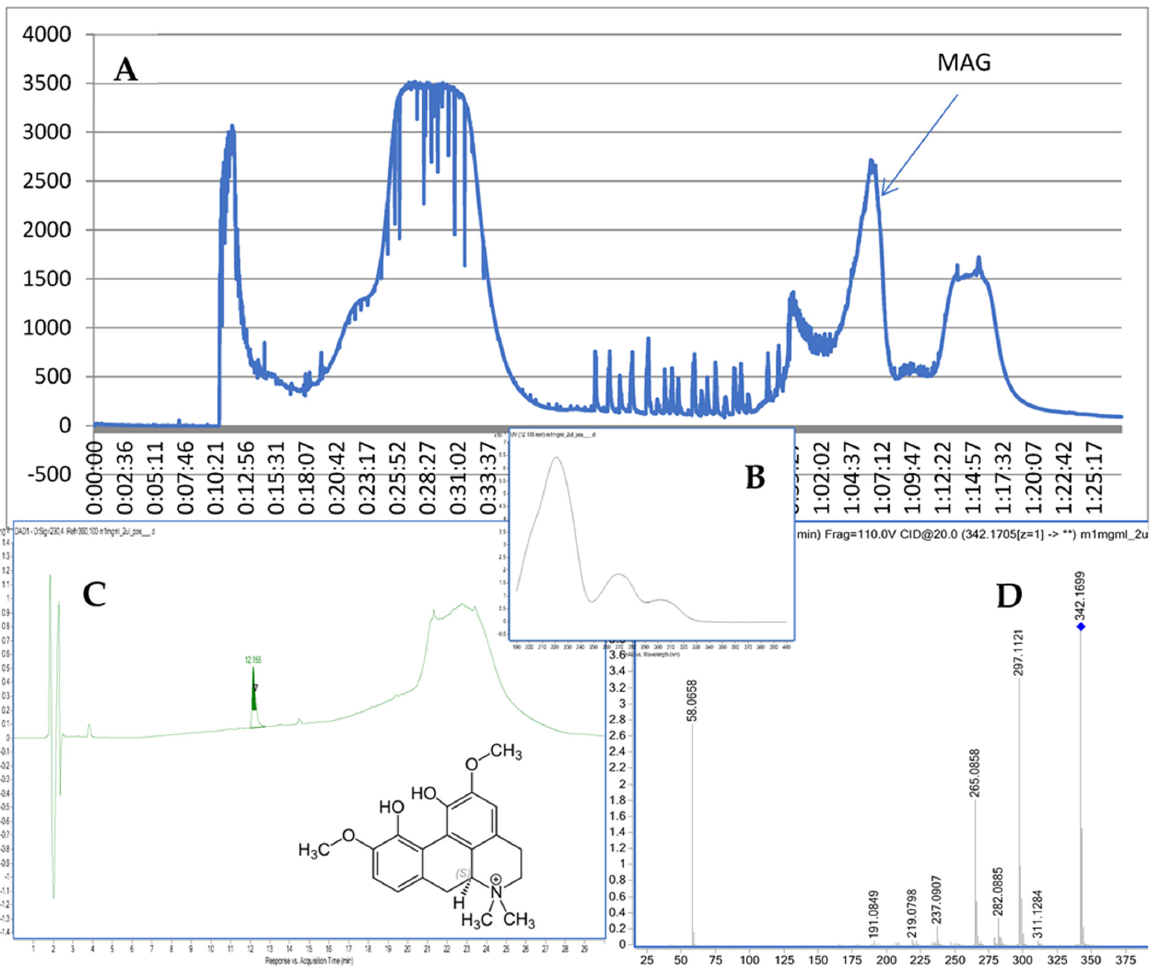
Figure 1. CPC chromatogram at 290 nm ( A ), the UV spectrum and structure of MAG ( B ), the purity check via HPLC ( C ), and the MS/MS spectrum of MAG ( D ).